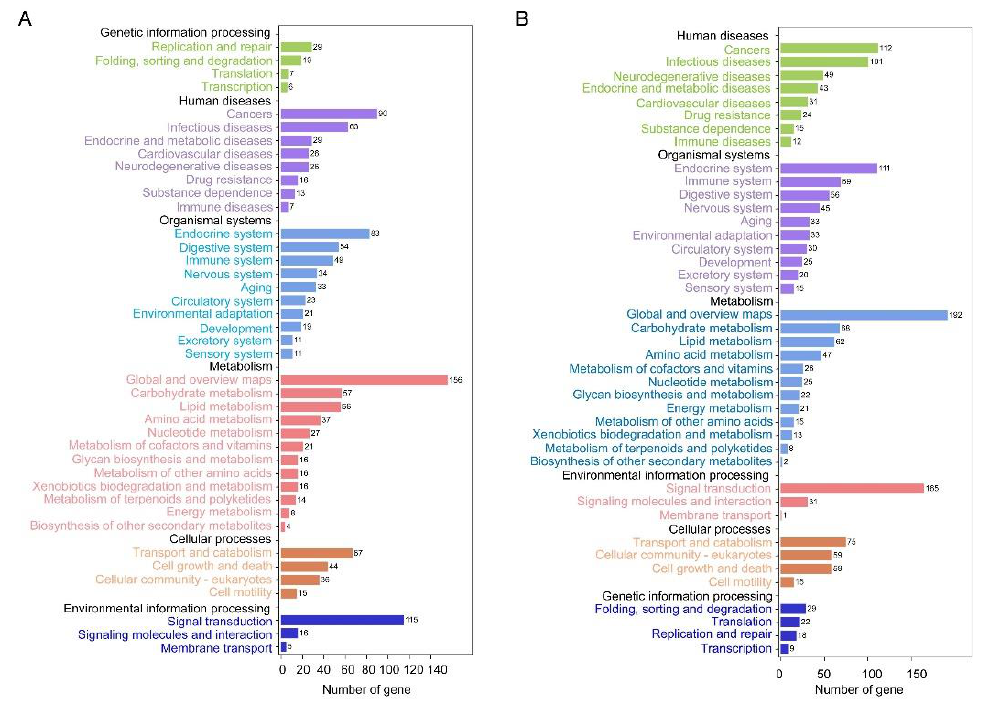
Figure 9. KEGG pathway classification of DEGs in the forewing ( A ) and hindwing ( B ) buds of 48 hAE-5th-star nymphs with NlFoxO and Gfp knockdown.